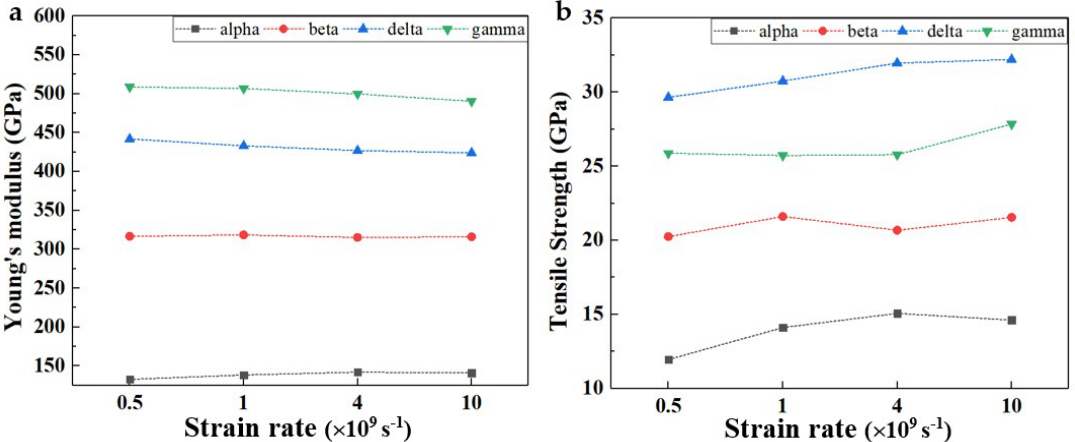
Figure 6. ( a ) Young’s modulus and ( b ) tensile strength for four types of graphyne under different strain rates.